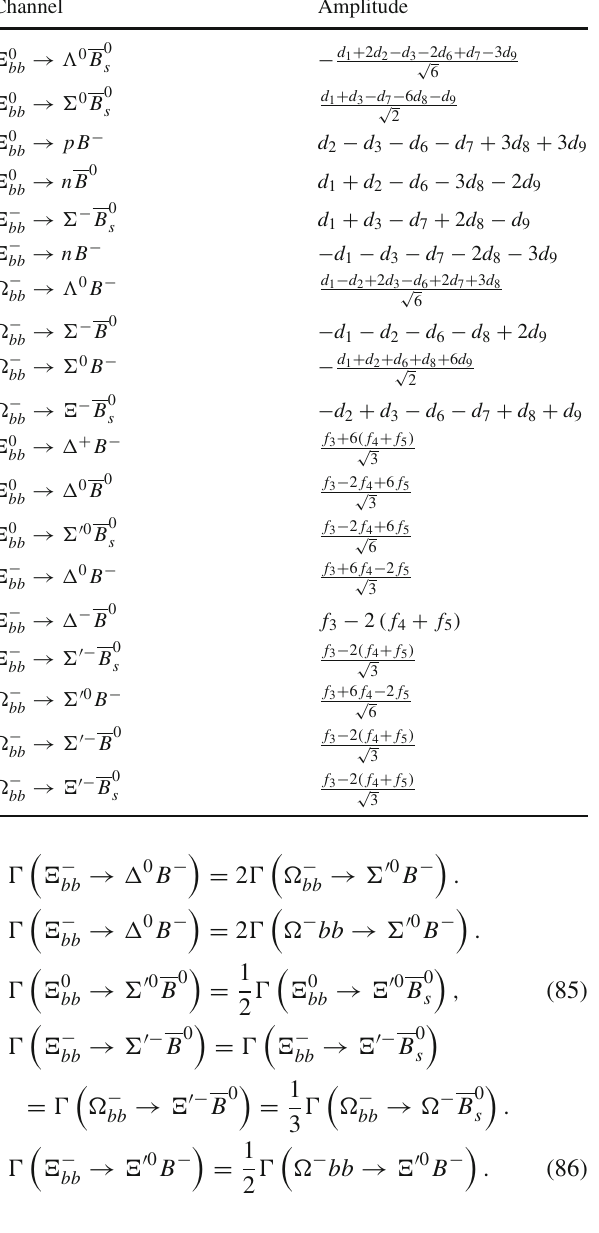
Table 20 Doubly bottom baryons decays into a bottom meson and a light baryon induced by the charmless b → s transitio Channel Amplitude